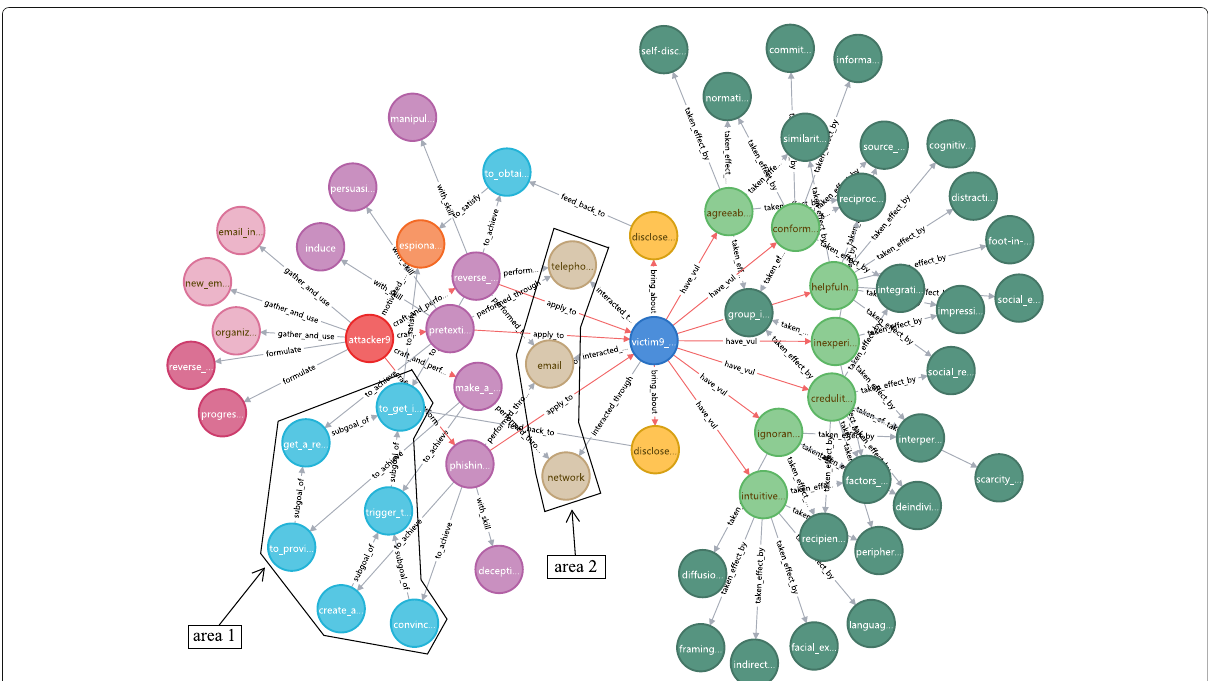
Fig. 20 Analyze single social engineering attack scenario (e.g. scenario 9) by knowledge graph